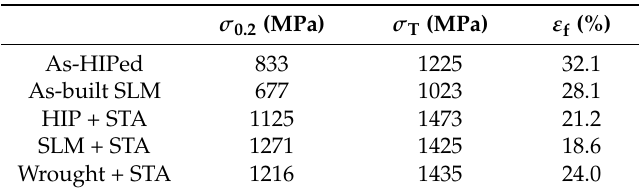
Figure 9. Engineering stress-strain curves of HIP specimen and SLM specimens at 650 °C. Table 2. Tensile properties at room temperature.